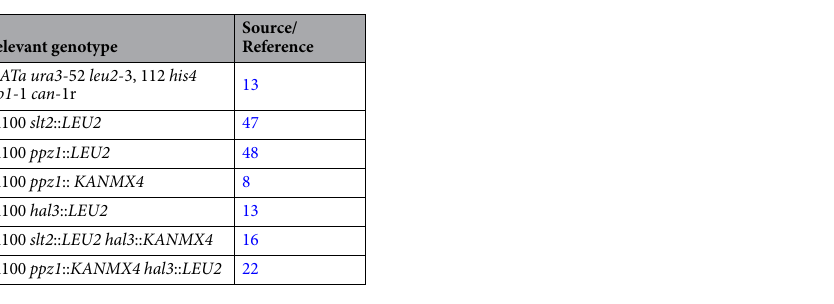
Table 3. Yeast strains used in this